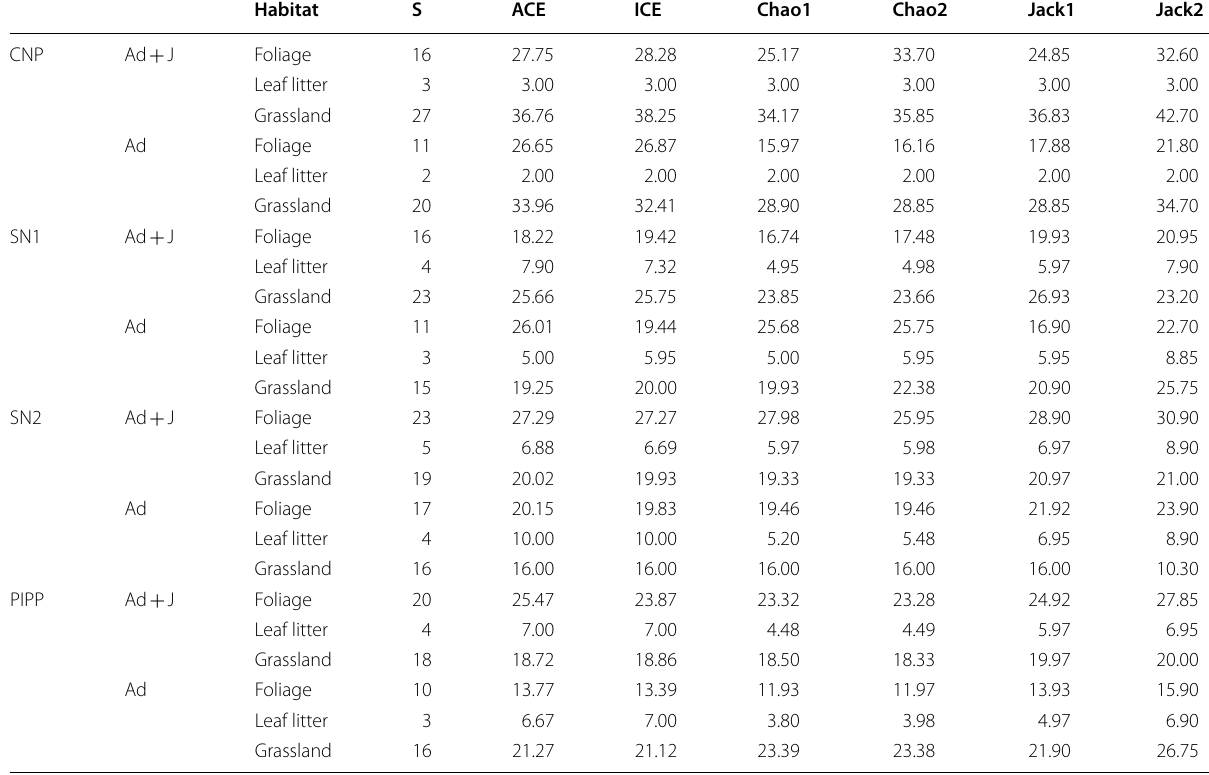
Table 4 Estimation of richness without HTS in the studied area, Eastern Chaco District,